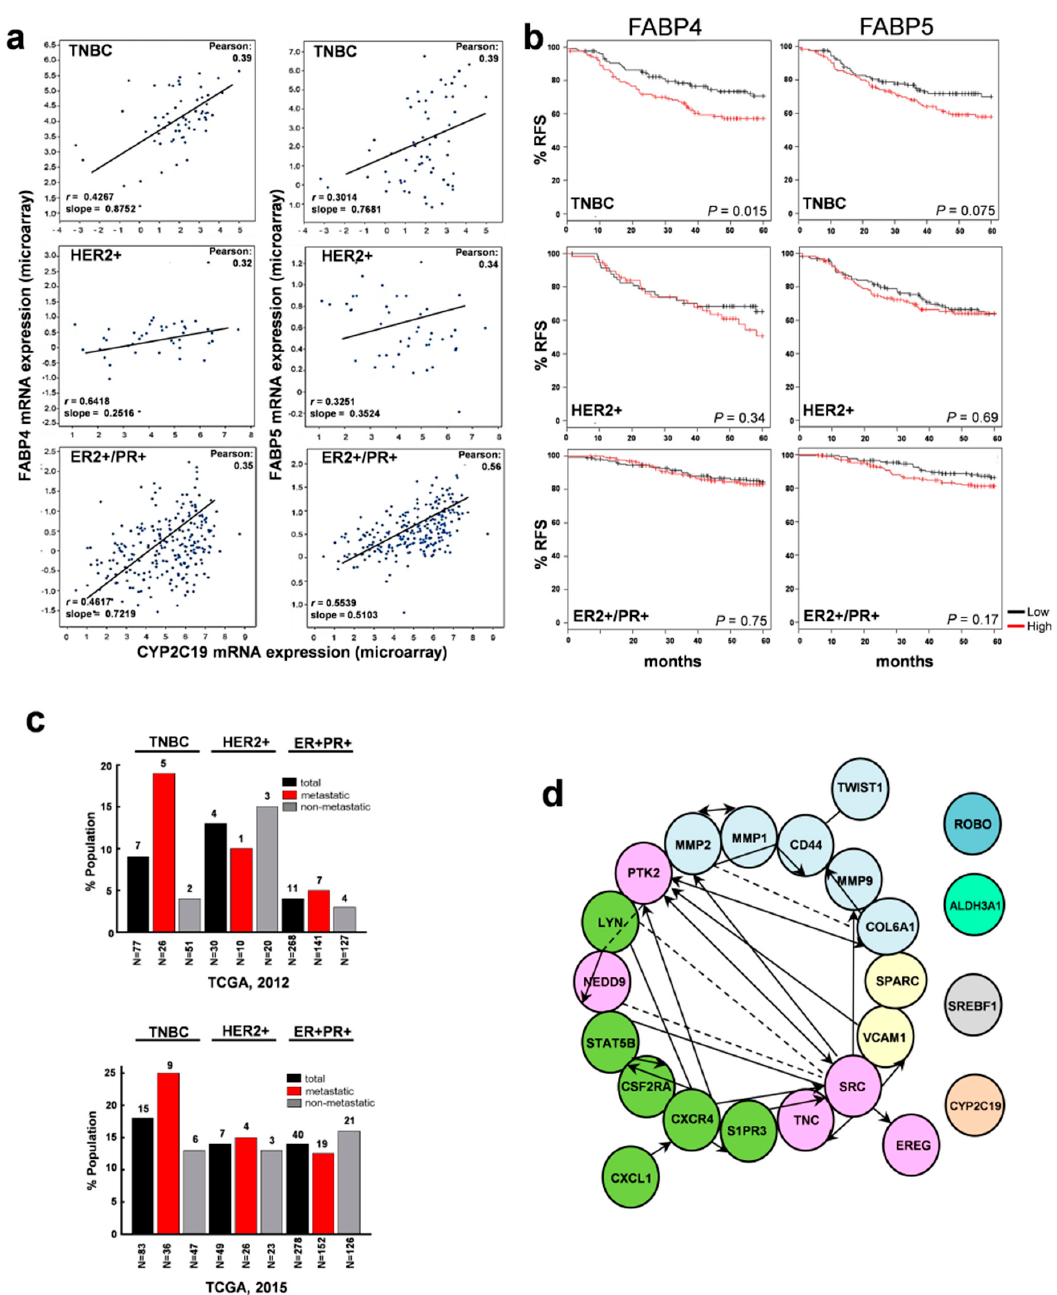
Figure 1. Concerted upregulation of CYP2C19, FABP4, and FABP5 is associated with metastasis transformation, stromal interaction network, and poor prognosis in TNBC. ( a ) FABP4 and FABP5 mRNA expression shows a positive co-expression profile when plotted against CYP2C19 epoxygenase in breast cancer tissues (two-tailed Pearson’s correlation analysis, p < 0.05, dataset from [25]). ( b ) Kaplan–Meier plots show relapse-free survival rates (RFS) of breast cancer patients classified according to hormone receptor subtype and stratified by either FABP4 or FABP5 mRNA expression level in tumors [34]. ( c ) Population distribution (%) of patients with concurrent CYP2C19, FABP4, and FABP5 upregulation in two independent, non-overlapping TCGA cohorts [25]. ( d ) Top upregulated genes in the FABP / CYP epoxygenase network visualized by cytoscape with a cut o ff value of significant relationships that